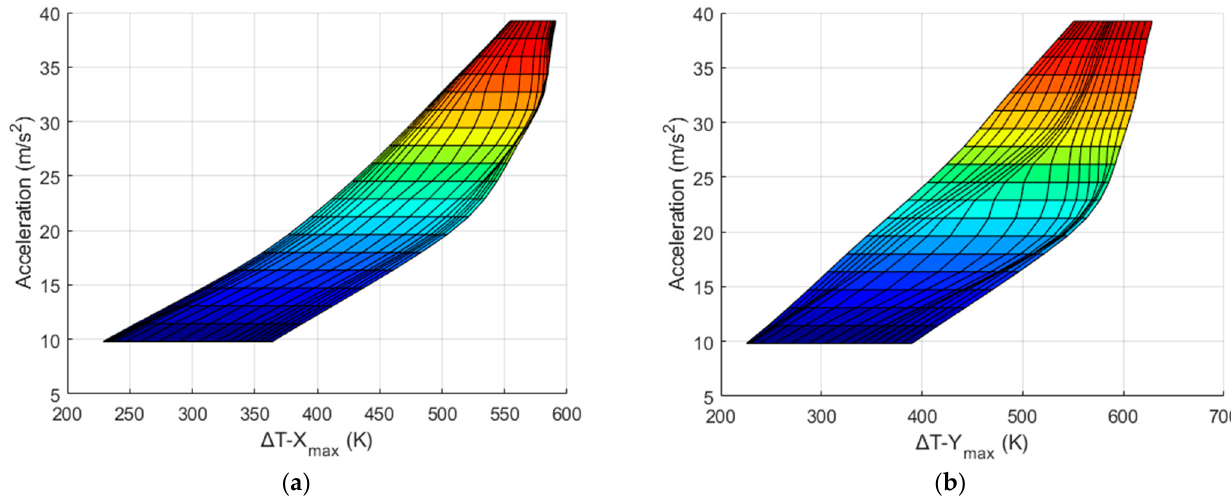
Figure 19. a w.r.t Δ T x ( a ) and Δ T y ( b ).